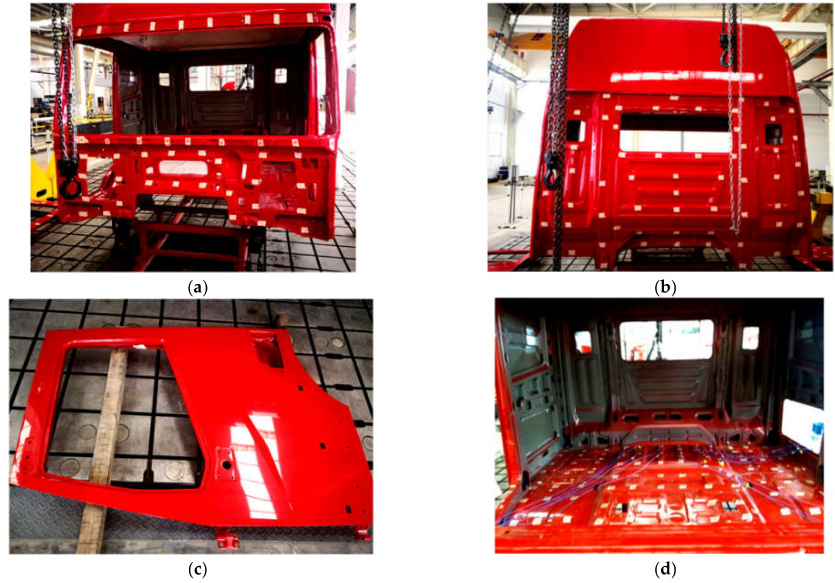
Figure 9. Measurement points of coupling loss factor of different structures. ( a ) Front coaming measur- ing point; ( b ) Rear coaming measuring point; ( c ) Door measuring point; ( d ) Floor measuring